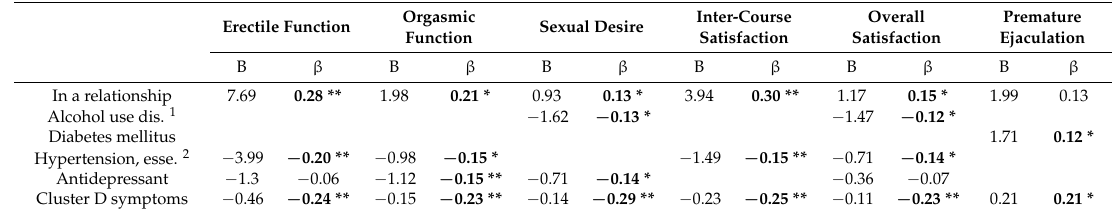
Table 2. Overview of individual significant predictors in the final step of hierarchical regression analysis for the overall